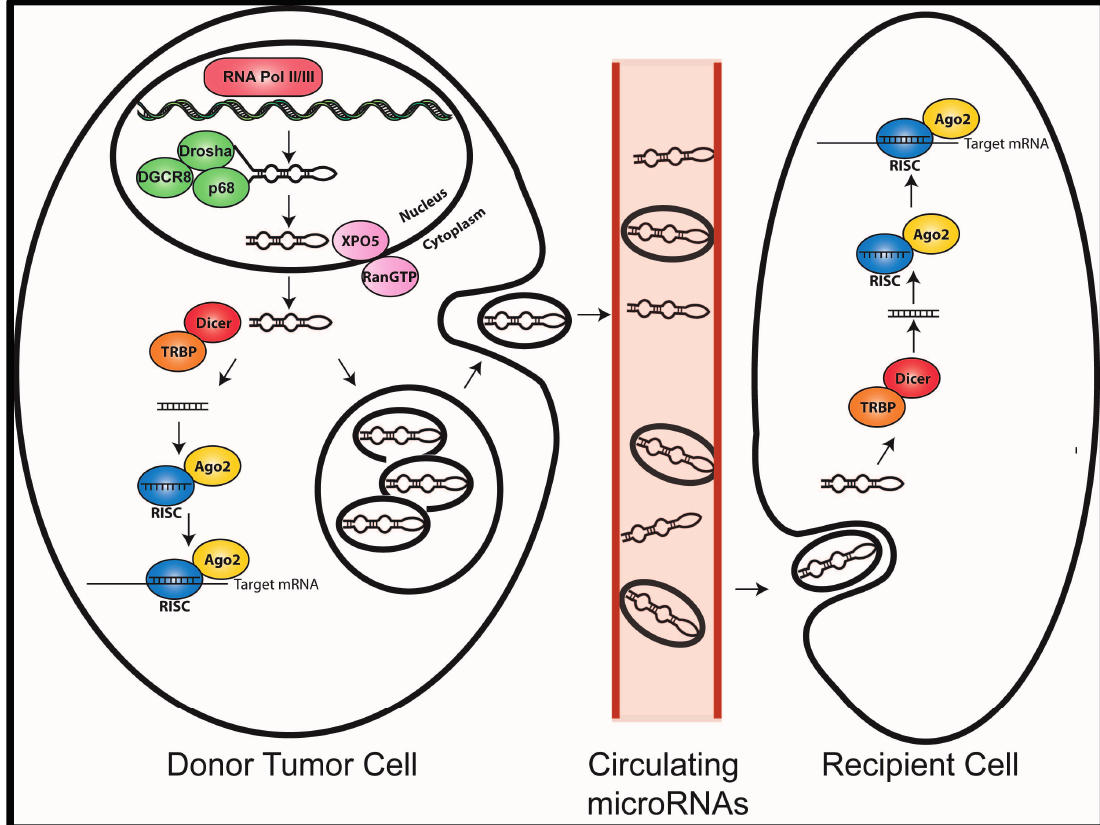
Figure 1. Cell–cell communication through exosomal microRNAs. MicroRNAs